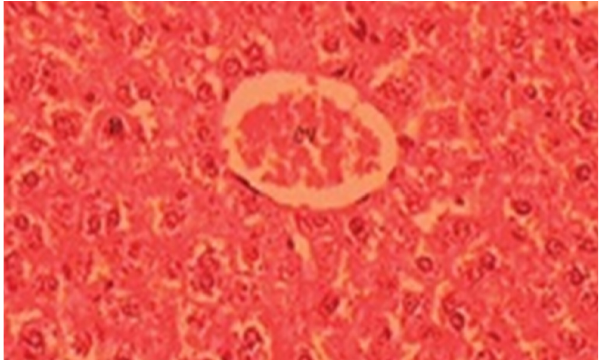
Fig. 2. Transverse section of the liver of a control rat showing he- patic cords arranged radially around the central vein and normal hepatocytes with centrally located nuclei